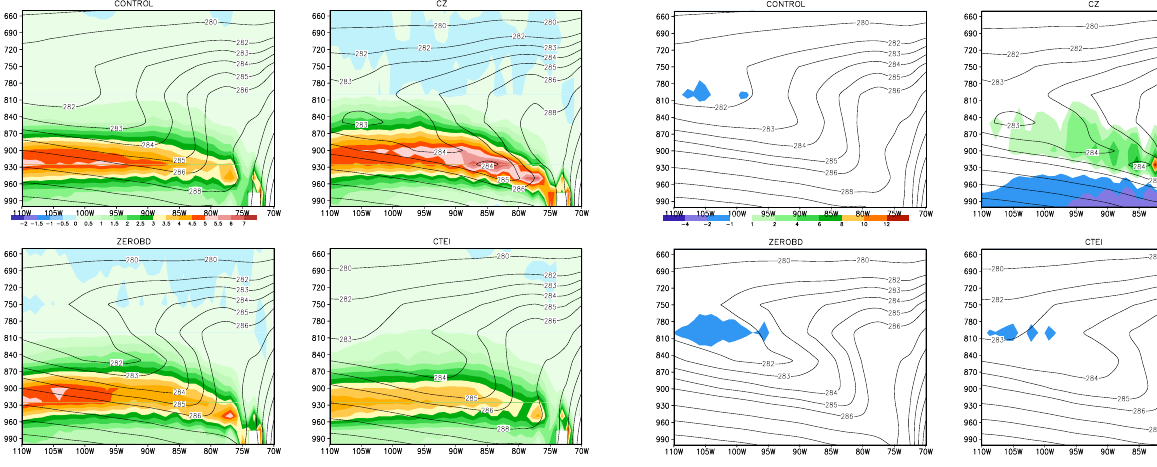
Fig. 13. As in Fig. 10 except for the heating rate (K/day) (shaded) due to large-scale